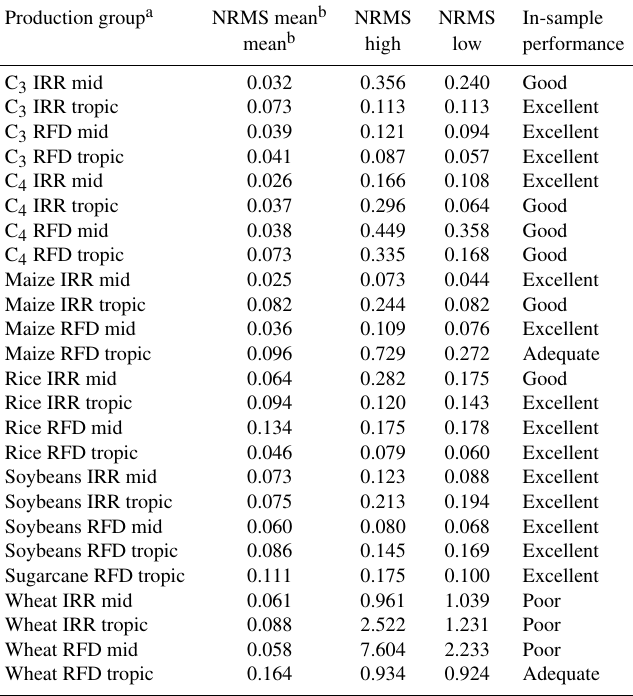
Table A3. Persephone v1.0 response function performance for all production groups, for C3MP µ CTW (Eq. A2), quadratic σ CTW (Eq. A6).